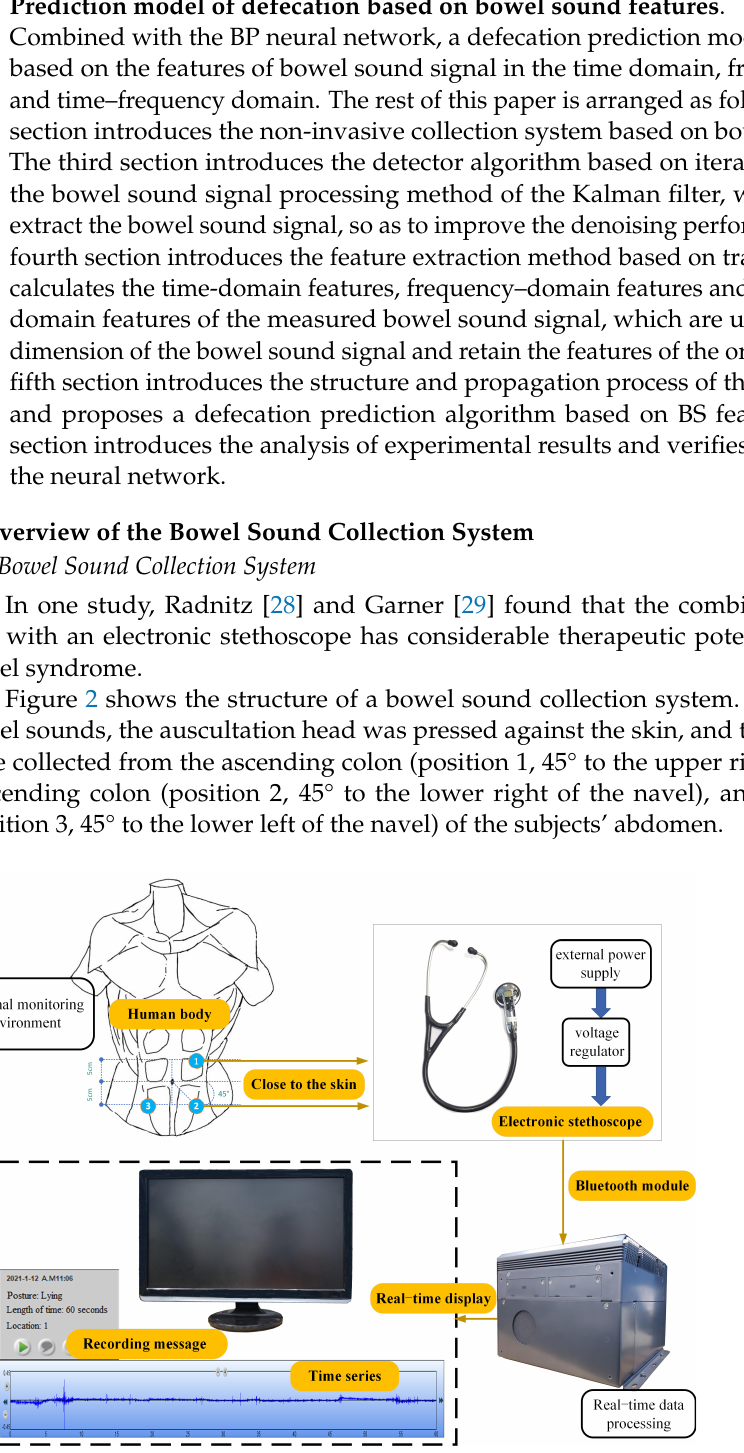
Figure 2. Hardware composition of the bowel sound collection